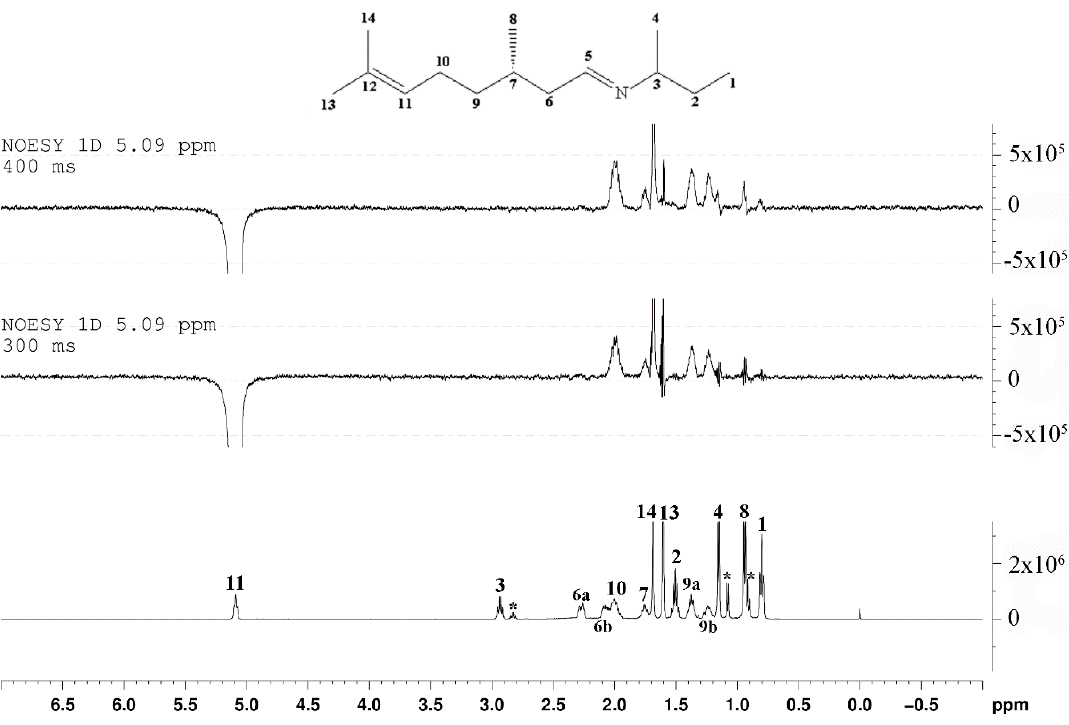
Figure 4. Expansions of spectra of the NOE experiment for an equimolar mixture of the diastereoisomers ( S,S and S,R ) of imine 5 at different mixing times (300 and 400 ms). Irradiated at 5.09 ppm (H11).